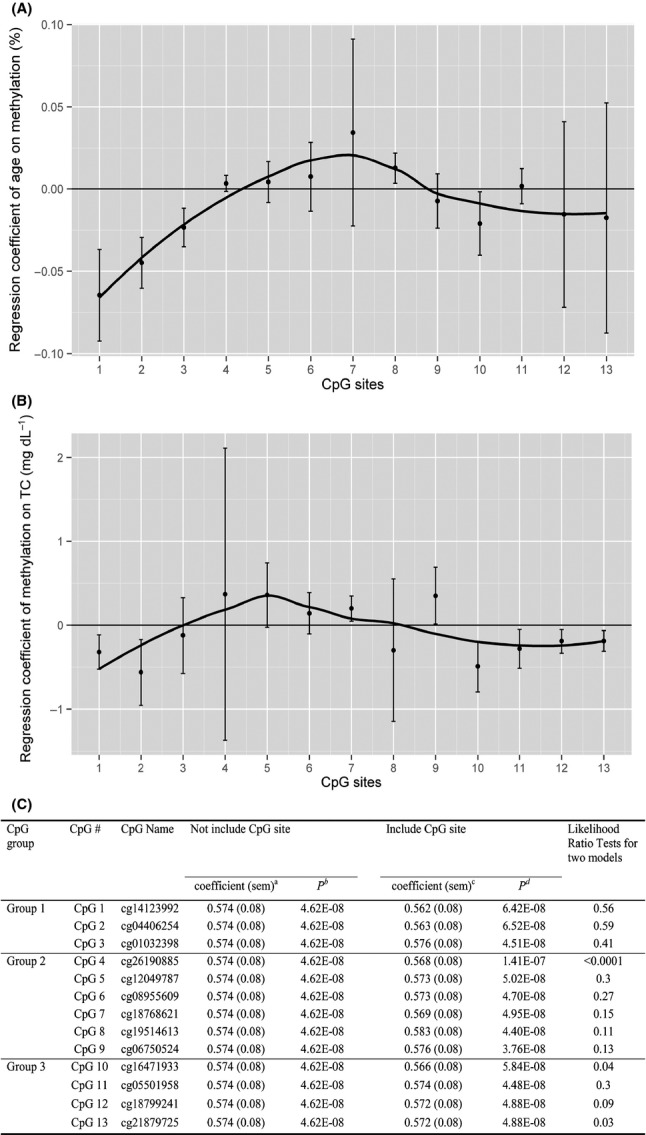
APOE methylation patterns may act as the intermediate factors of the effects of age on blood lipids. Panels A and B provided qualitative evidence by listing 13 CpG sites as x-axis and the y-axis are the regression coeffiecients of age for the outcome of methylation (%) (A) and the regression coefficients of methylation for the outcome of TC (mg dL−1) (B). Black dot represents point estimate of regression coefficient for each CpG site from generalized linear models adjusting for pedigree, gender, study center, and the first principal component of cellular purity and population structure. Lower and upper bars represent the lower and higher values of 95% confidence intervals for each coefficient. Black line is the fitted line for the pattern of all 13 CpG sites. Panel C provided quantitative evidence based on the likelihood ratio test of the differences in the regression coefficients of the effects of age on TC yielded by the model without and with the adjustment of APOE methylation. aCoefficient and SEM, and bP represent the magnitude and significance of the changes in blood total cholesterol (mg dL−1) corresponding to 1 year increase in age adjusting for pedigree, sex, center, and the first principal component of cellular purity and population structure; cCoefficient and SEM, and dP represent the magnitude and significance of the changes in blood total cholesterol (mg dL−1) corresponding to 1 year increase in age with further adjustment for the methylation levels of each CpG site at APOE locus in addition to pedigree, sex, center, and the first principal component of cellular purity and population structure.